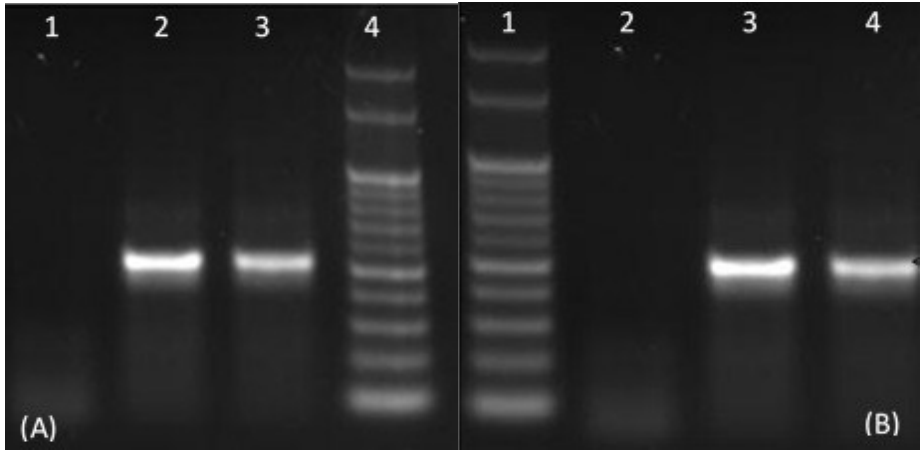
Figure 1. Representative gel picture of PCR amplified product of RT ( A ) and PR genes ( B ) of HIV-1 infected pediatric patient. For RT; Lane 1: Negative control, lane 2 and 3 contains 539 bp amplicon of RT gene of two representative HIV-1 infected children and lane 4:100 bp ladder. For PR; Lane 1: 100 bp DNA marker, lane 2: Negative control and 3 and 4: 514 bp amplicon of PR gene of two representative HIV-1 infected